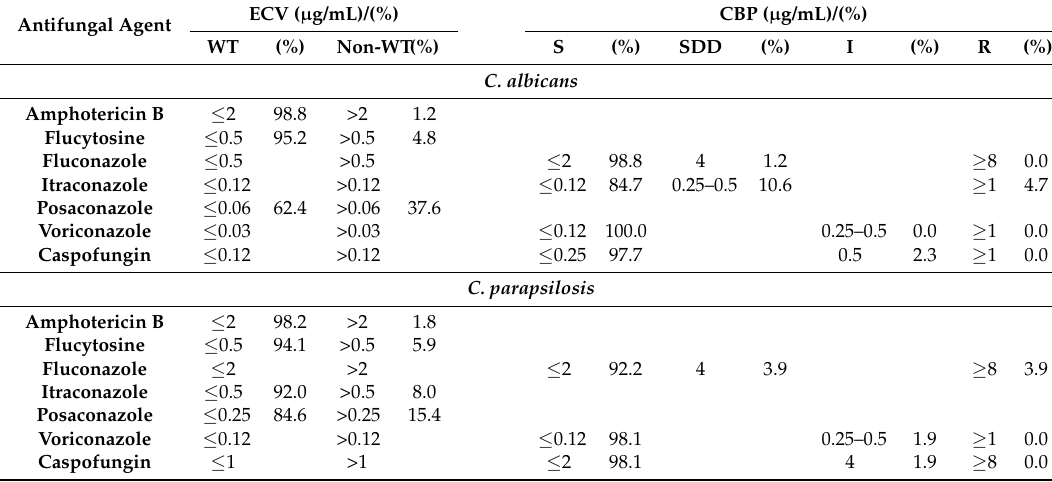
Table 4. Susceptibility rates of C. albicans isolates ( n = 85) and C. parapsilosis ( sl ) isolates ( n = 51) according to Clinical and Laboratory Standards Institute (CLSI) breakpoints during the study period (2008–2017).